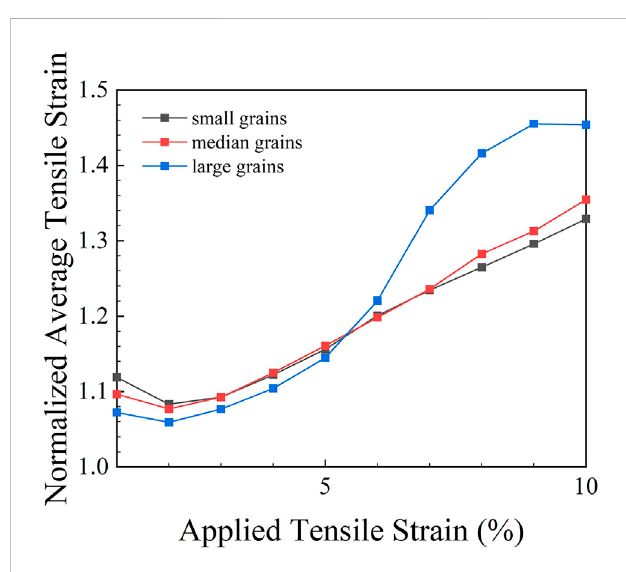
FIGURE 4 Partitioning of average tensile strain in x-axis in GNG structured